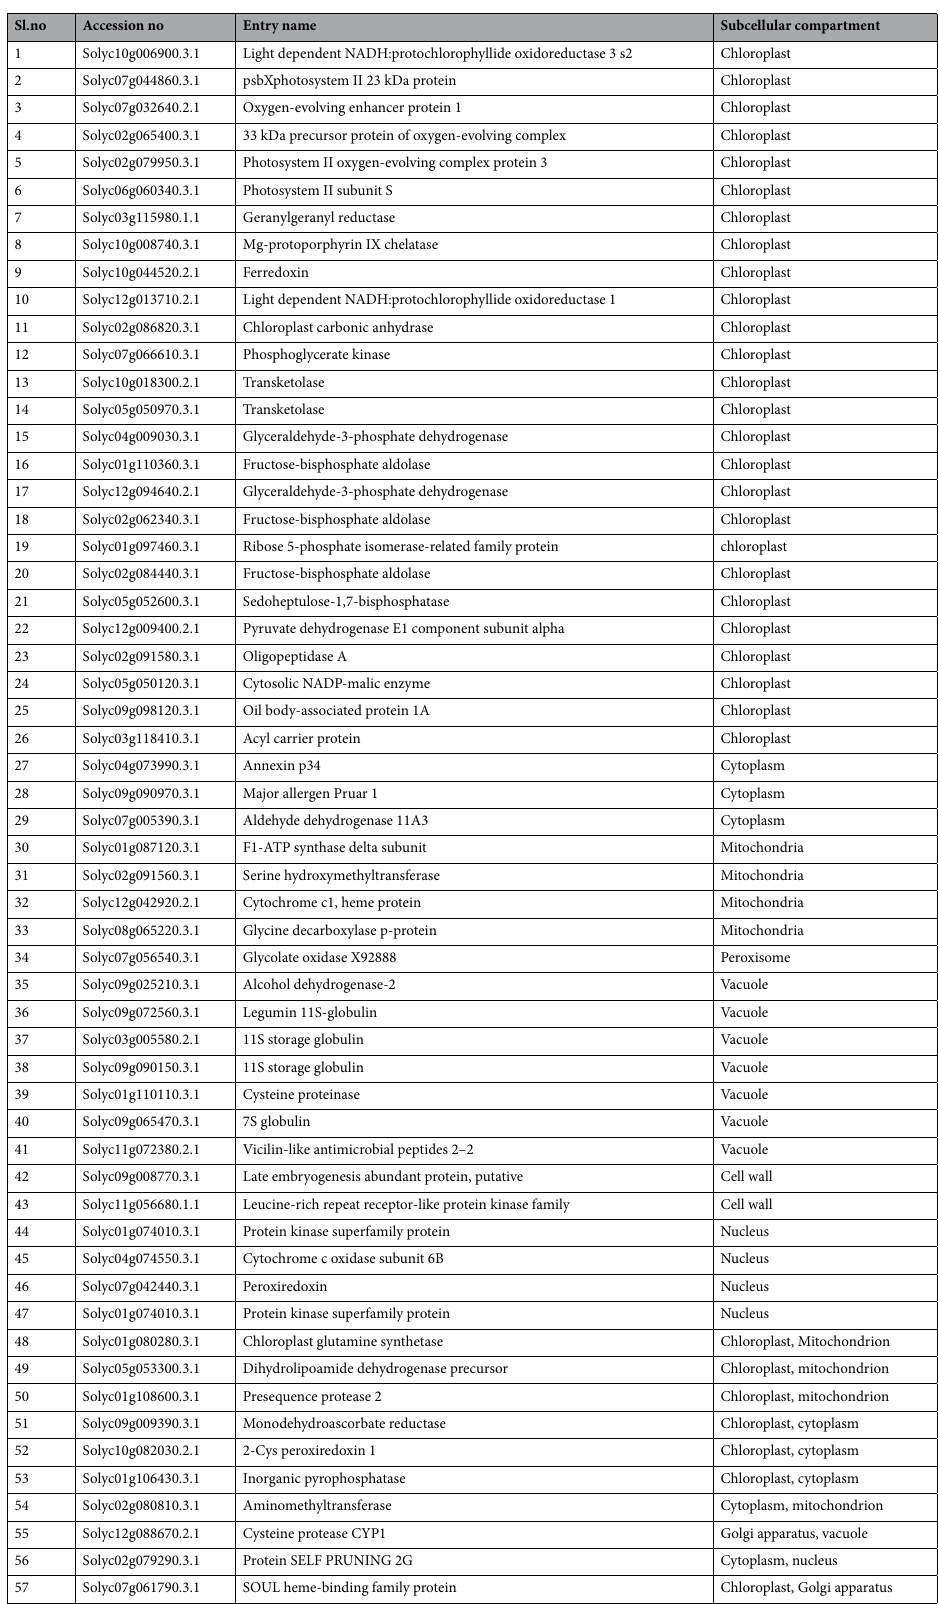
Table 1. Proteins within each subcellular location group. Accession number and description from the International Tomato Annotation Group (ITAG) release version